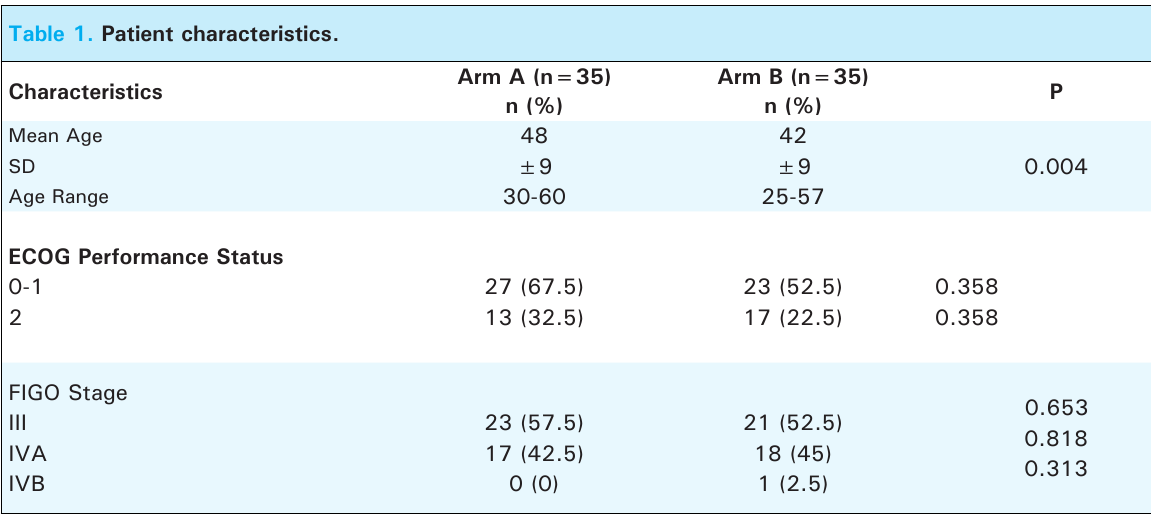
Table 1. Patient characteristics.